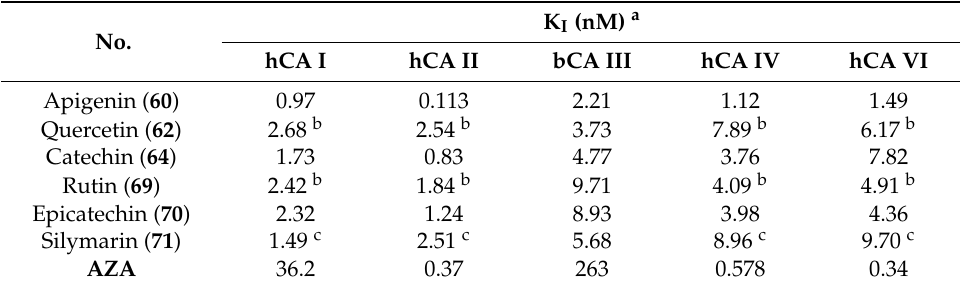
Table 8. K I values ( µ M) for compounds 60 , 62 , 64 , 69 – 71 and AZA of some human (h) and bovine (b) α -carbonic anhydrase isoforms (by an esterase assay) [67].